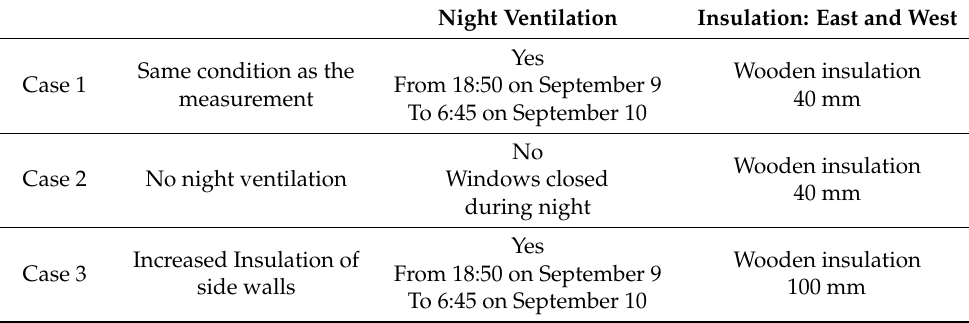
Table 3. Calculation conditions: Insulation.